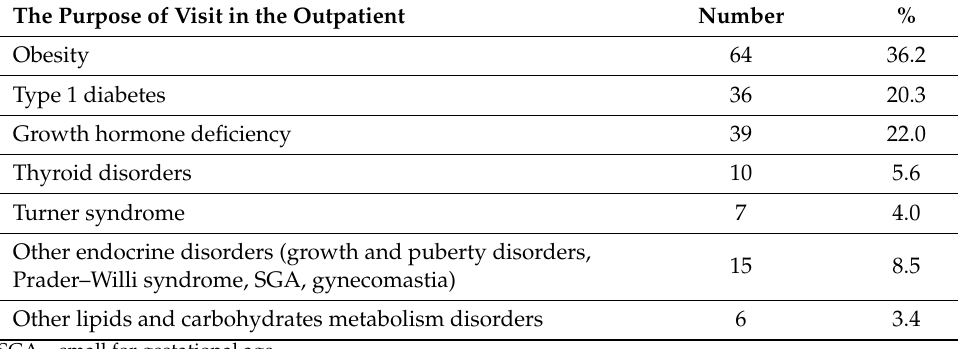
Table 1. The purpose of the visit in